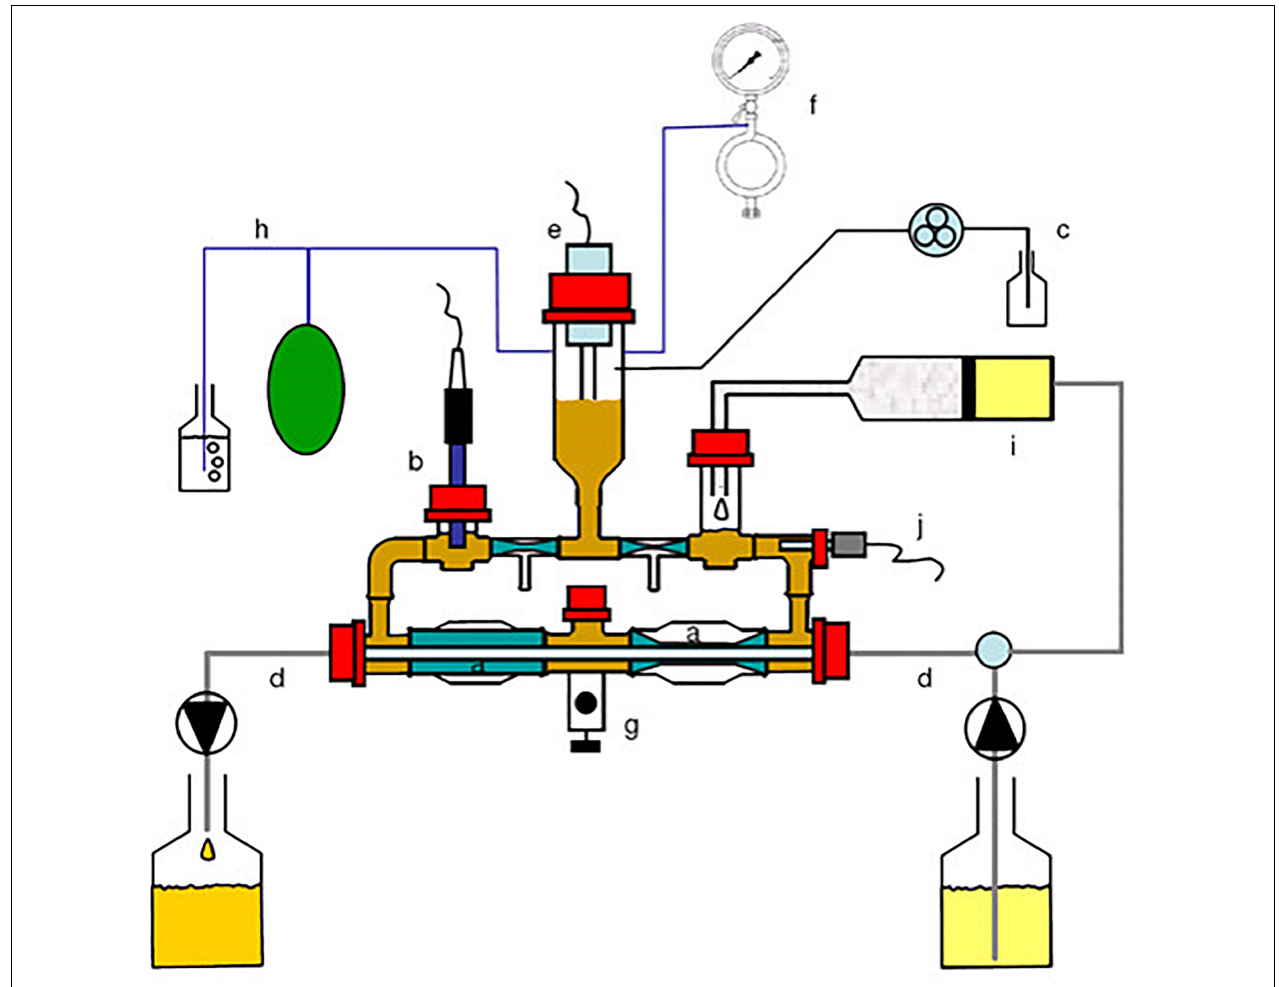
FIGURE 1 | Schematic representation of Chicken ALIMEntary tRact mOdel-2 (CALIMERO-2). a = Peristaltic compartments with a dialysis membrane inside; b = pH sensor; c = NaOH inlet; d = dialysate system; e = level sensor; f = gaseous N 2 inlet; g = sampling port; h = gas outlet; i = feeding syringe; j = temperature